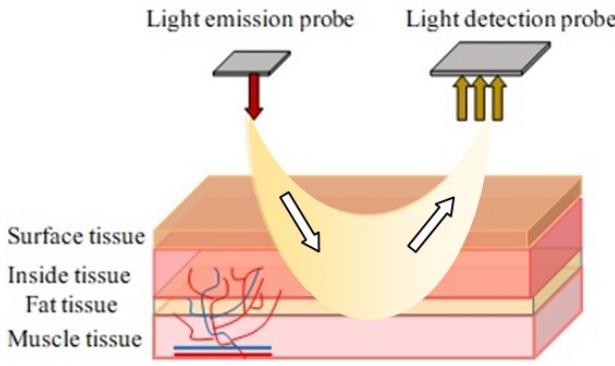
Figure 3. Structural diagram of a tissue oximeter sensor operating on a reflected